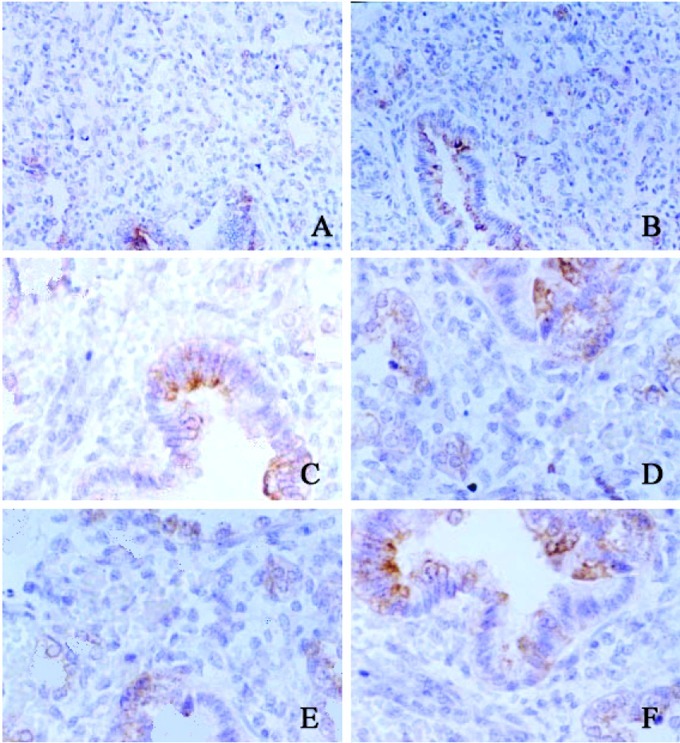
SP-B mRNA expression in different groups (positive cells, yellow). (A) RDS group (26 weeks, x100); (B) control (26 weeks, x100); (C) RDS group (34 weeks, x400); (D) control (34 weeks, x400); (E) RDS group (38 weeks, x400) and (F) control group (38 weeks, x400). RDS, respiratory distress syndrome.